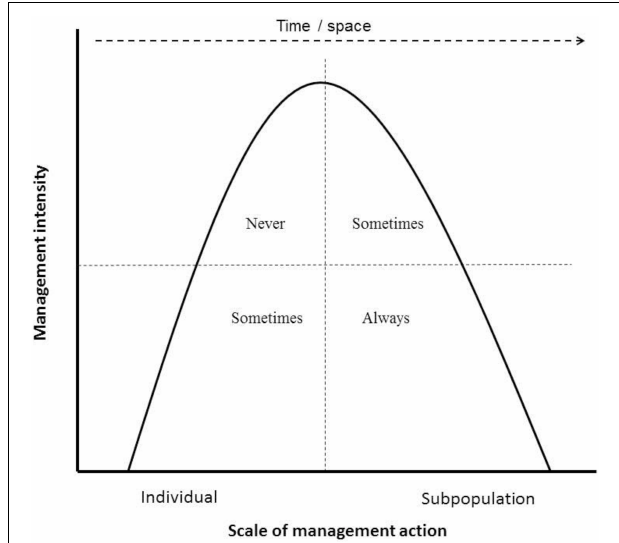
FIGURE 2 | The hypothetical relationship between management intensity and scale of management action related to the subpopulation’s inclusion in the Red List. High-intensity management at the individual level (for example, selective breeding of Roan Antelope individuals within a herd) should never be included in the assessments. Low-intensity management at the individual scale can be included only if withdrawal of that intervention would not result in the decline of the subpopulation over the short term (c. 10 years). For example, providing supplementary food to a Sable herd during a drought is accepted, but not regularly providing supplementary food. High-intensity management aimed at the subpopulation scale can be included if the intervention is aimed at increasing the resilience of the overall populations. For example, the large flightless takahe Porphyrio hochstetteri , which has large area requirements and very low population sizes at individual sites requires managers to move individual animals between sites (currently including two fenced sites) to avoid inbreeding (i.e., metapopulation management), is a situation where the individuals are likely to survive in the protected area but in the long-term will need help to ensure genetic diversity. However, translocations and introductions that could lead to inbreeding or outbreeding depression or hybridization (i.e., not part of a metapopulation plan) are not included. Finally, low-intensity management aimed at the subpopulation level are always included in the Red List, for example, periodic supplementation of the subpopulation to enhance genetic diversity or broad habitat management to ensure key resource areas are